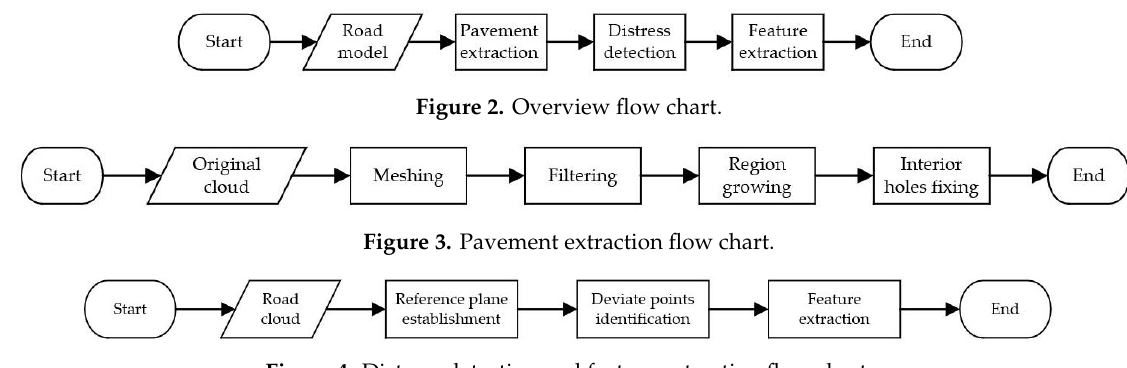
Figure 1. Three-dimensional (3D) model examples ( a ) and ( b ) in the form of point clouds.